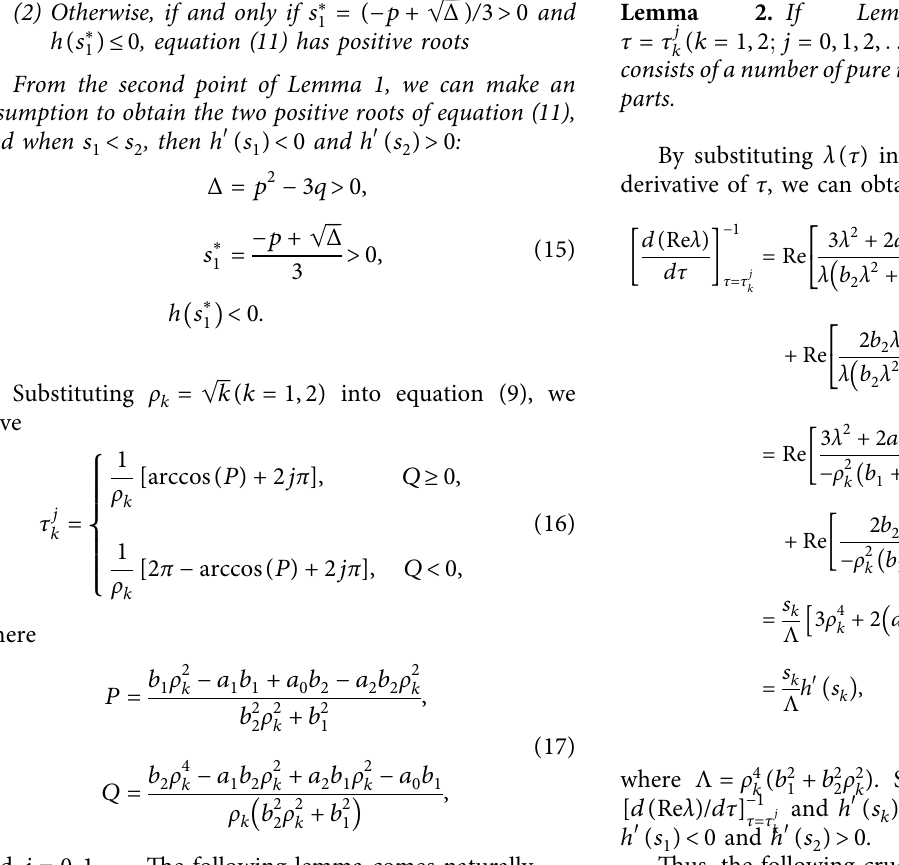
Figure 1: For parameter values ( a, b,c, k, k (1) without delay tends to stable equilibrium when IC � ( 30 , 30 , − 9 ) ; (b) system (1) without delay has a chaotic attractor when IC � ( 0 . 98 , − 1 . 82 , 0 . 01 )